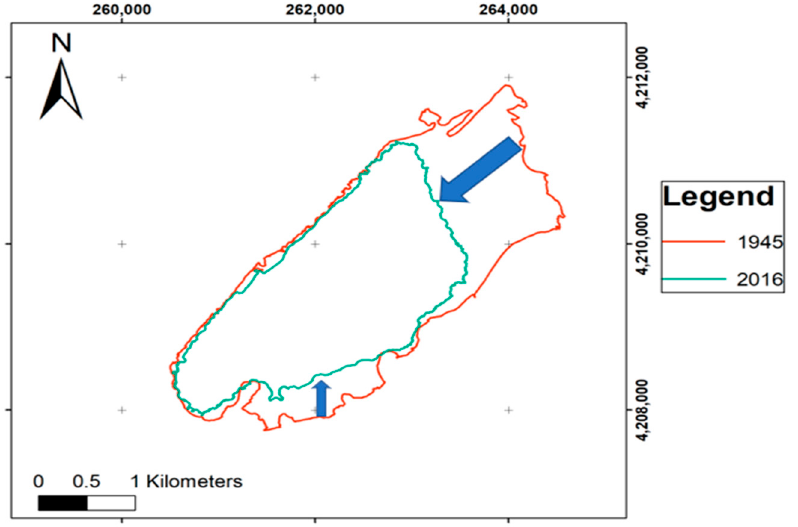
Figure 12. Kotychi Lagoon’s major areas of shrinkage (blue arrows) during the 1945–2016 period. On the other hand, the LRR values showed that the northern part was in a stable state, as the LRR was only 0.85 m/year for the 71-year period, showing that the narrow